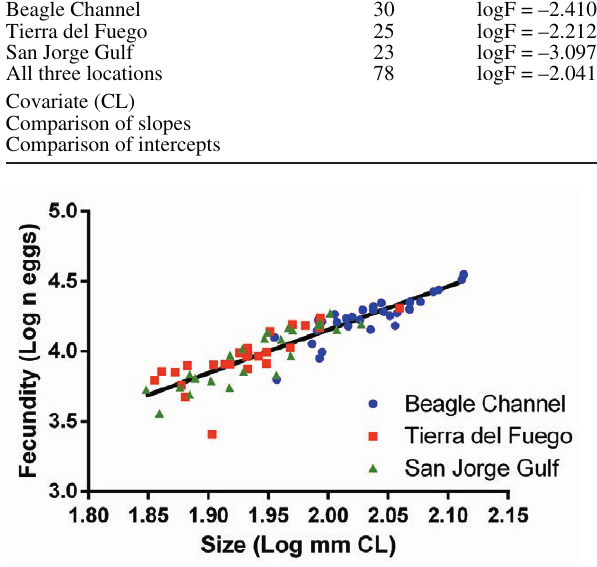
Table 1. – Linear regressions between fecundity (F) and female size (CL) for Lithodes santolla , among the three sampling sites. Categorical variable